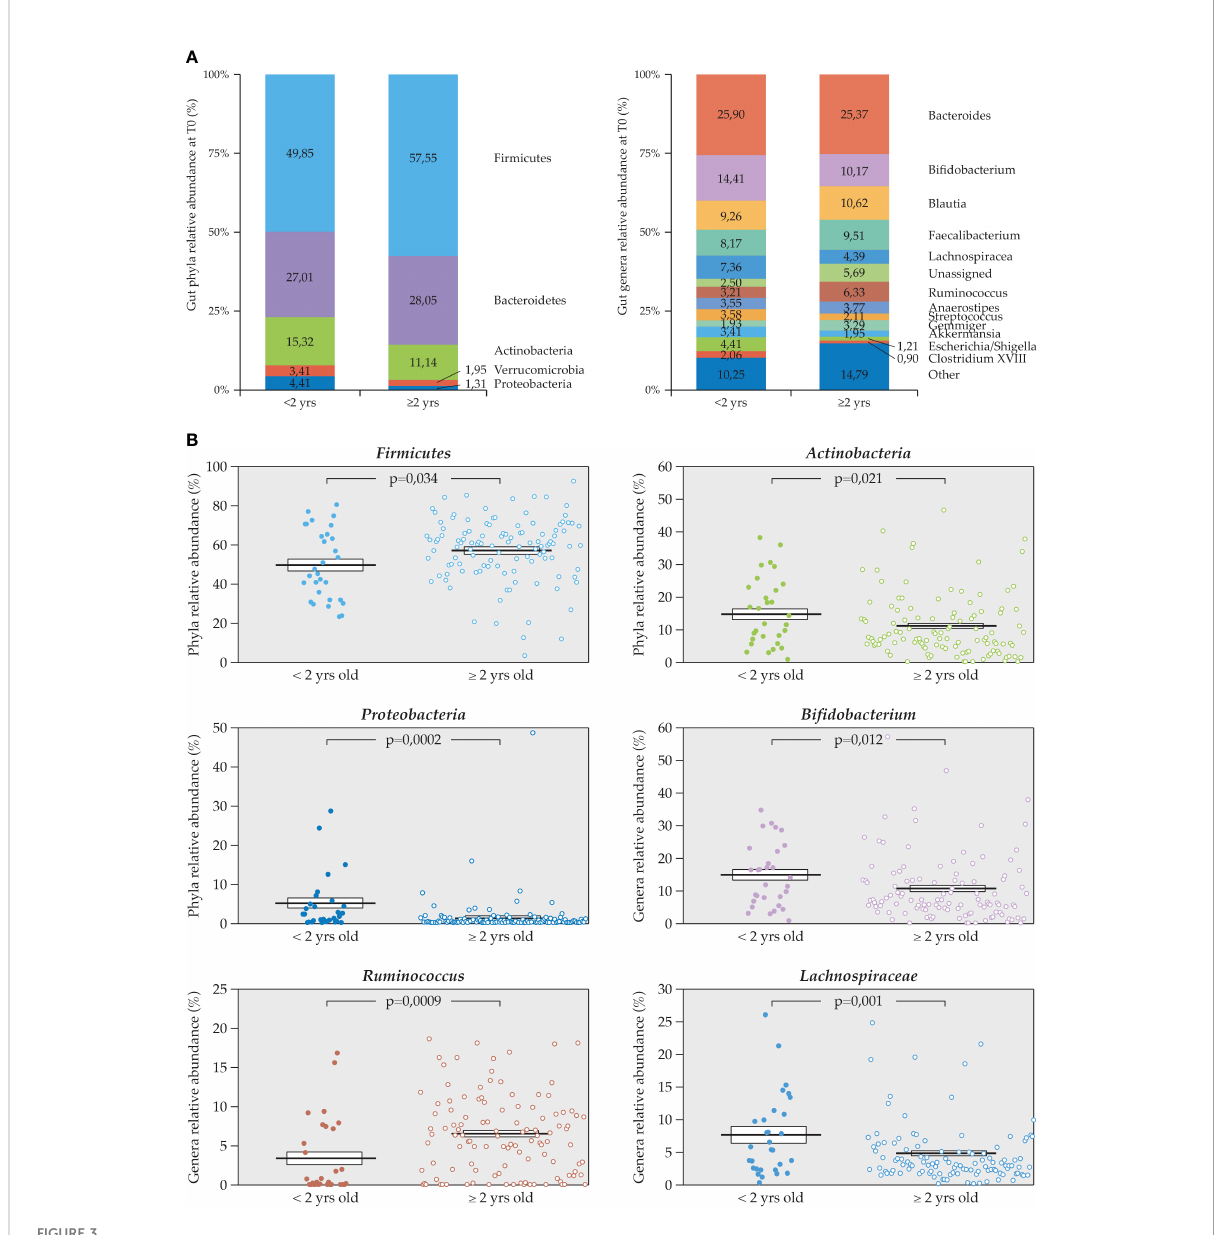
FIGURE 3 Relative percentage abundance of phyla and genera in the gut microbiota at T0. (A) Comparison between <2 ( n = 30) and ≥ 2 years of age ( n = 114) subgroups, (B) statistically signi fi cant differences in relative abundance of speci fi c taxa, Firmicutes, Proteobacteria , and Actinobacteria (phyla) and Bi fi dobacterium, Ruminococcus , and Lachnospiraceae (genera) in the two age subgroups (Mann U Whitney